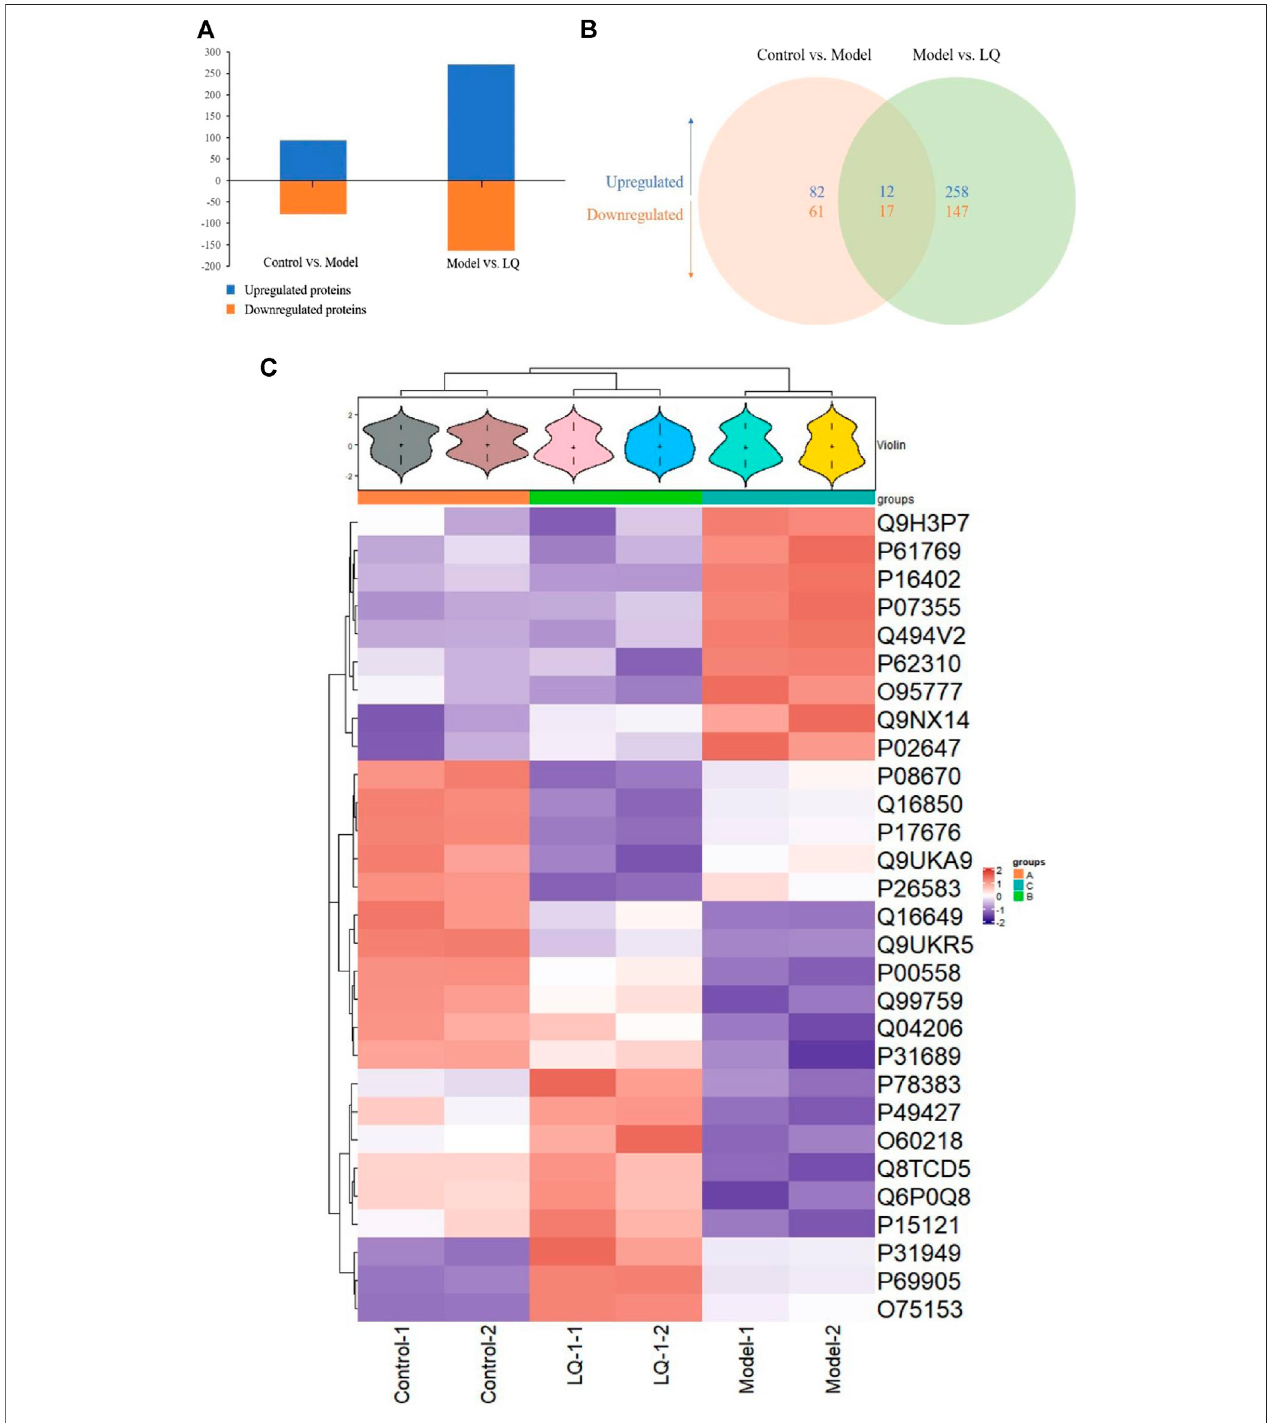
FIGURE 7 | iTRAQ-bases quanti fi cation of the proteomes. (A) The number of up- and downregulated proteins in the two-comparison group. (B) Venn diagram of the distribution in each comparison group. (C) Heatmap of the 29 common differentially expressed proteins. Model: Hypoxia/reoxygenation; LQ: Liquiritin.